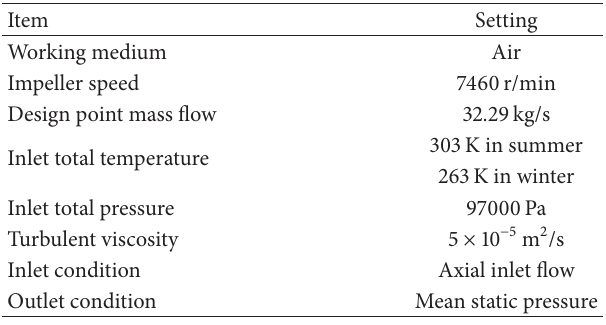
Table 1: Calculation parameters and boundary conditions.